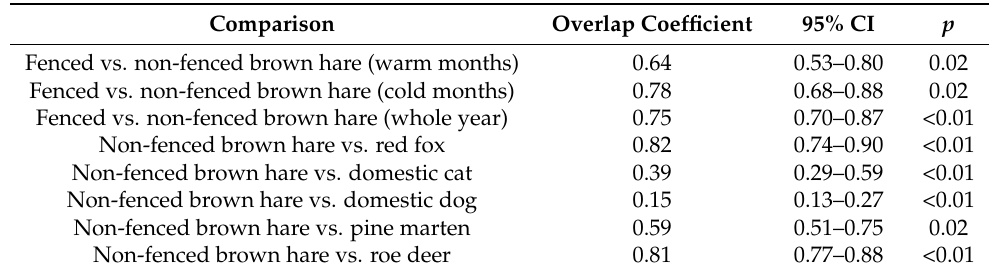
Figure 2. Overlap of activity rhythms of the brown hare in natural conditions and in the fenced area. Table 1. Coefficients and 95% confidence intervals (CIs) of activity overlap between the brown hare and its potential predators and competitors. p -values ( p ) obtained by testing whether the two sets of observations come from the same circular distribution are also